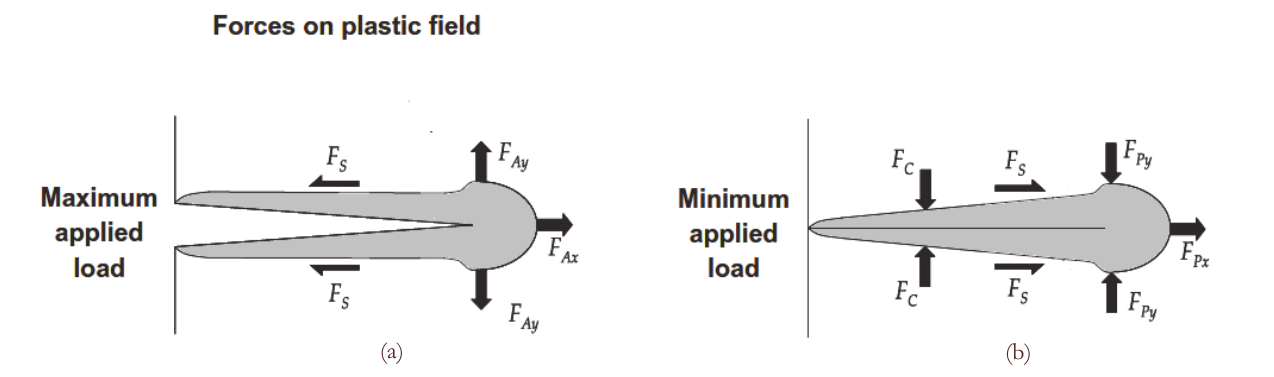
Figure 3: Forces between the plastic enclave (grey), and the surrounding elastic material (after